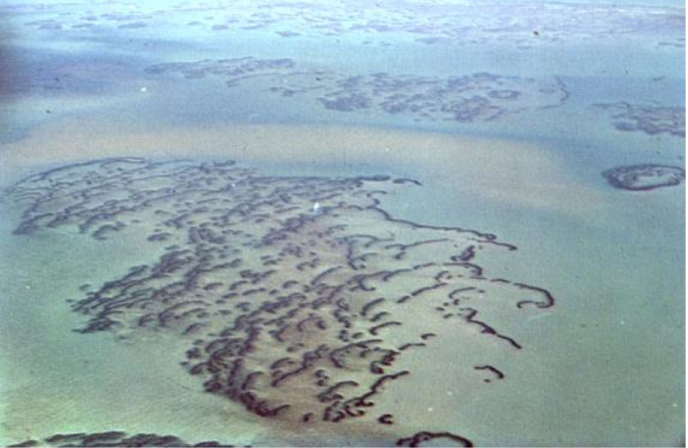
Figure 4. A striped meadow of Posidonia oceanica . Kerkennah Islands, Tunisia. From Blanpied in [55].